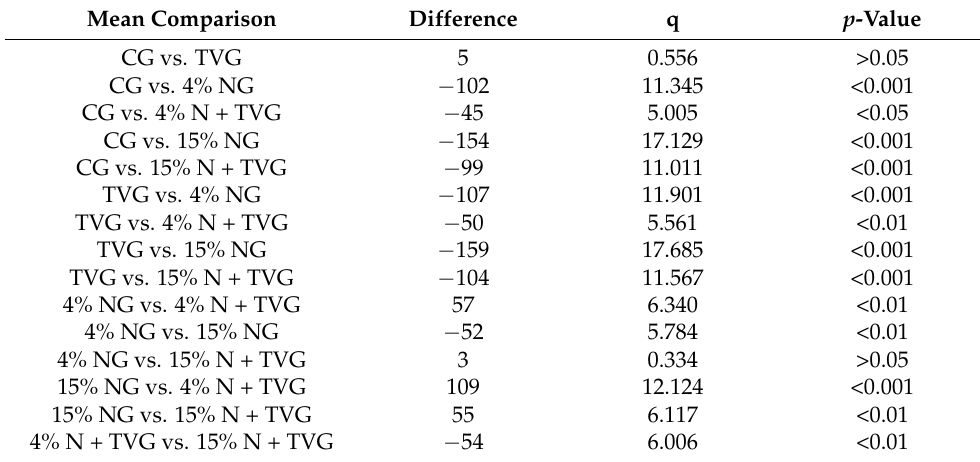
Table 4. Statistical analysis of H-scoring between groups. Mean